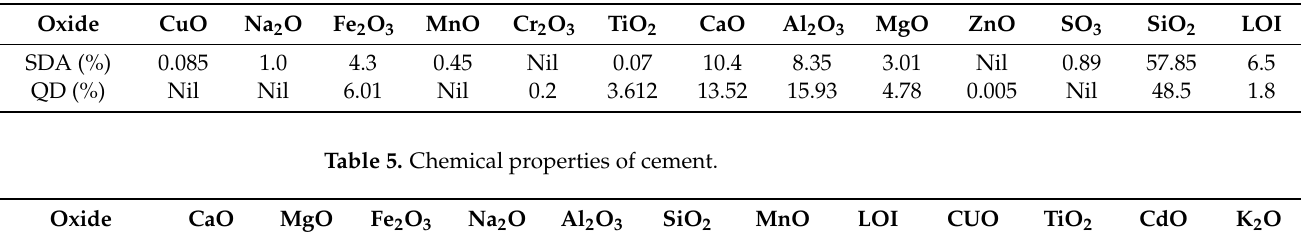
Table 4. Chemical constituents of samples using X-ray fluorescence (XRF).